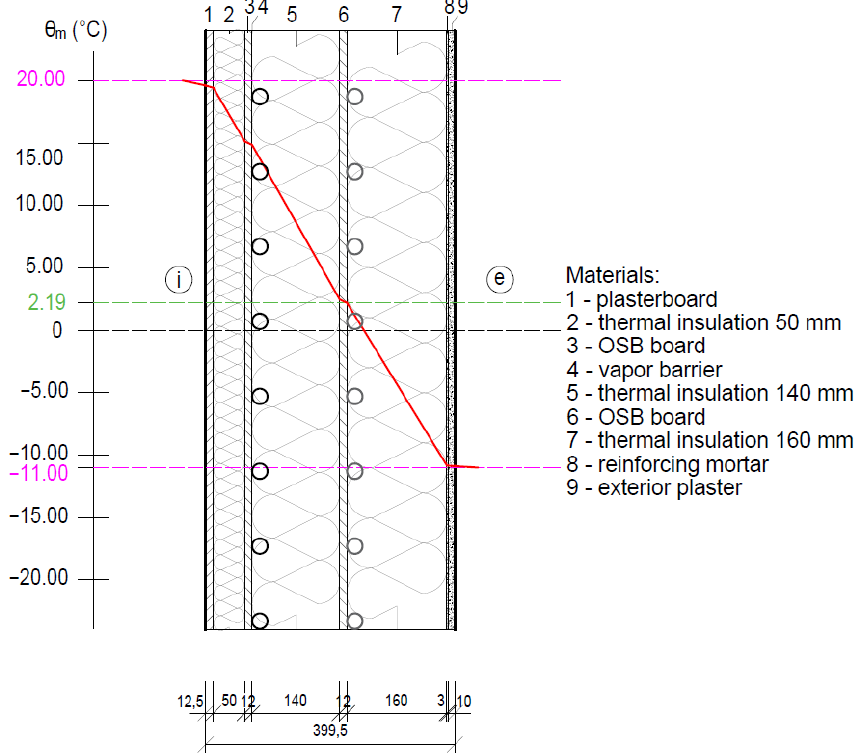
Figure 27. Temperature behavior in the construction of a prefabricated timber house. θ m —temperature in construction (°C), e—exterior, and i—interior.